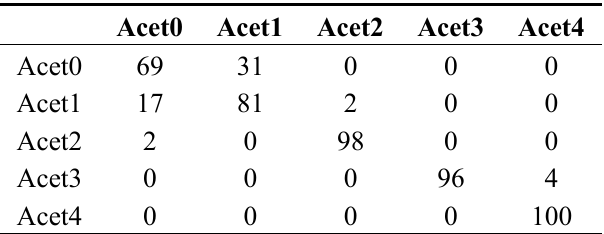
Table 3. Confusion matrix, calculated with the 50 simulations generated applying 10 rounds of 5-fold cross-validation over the 50 prototypes.